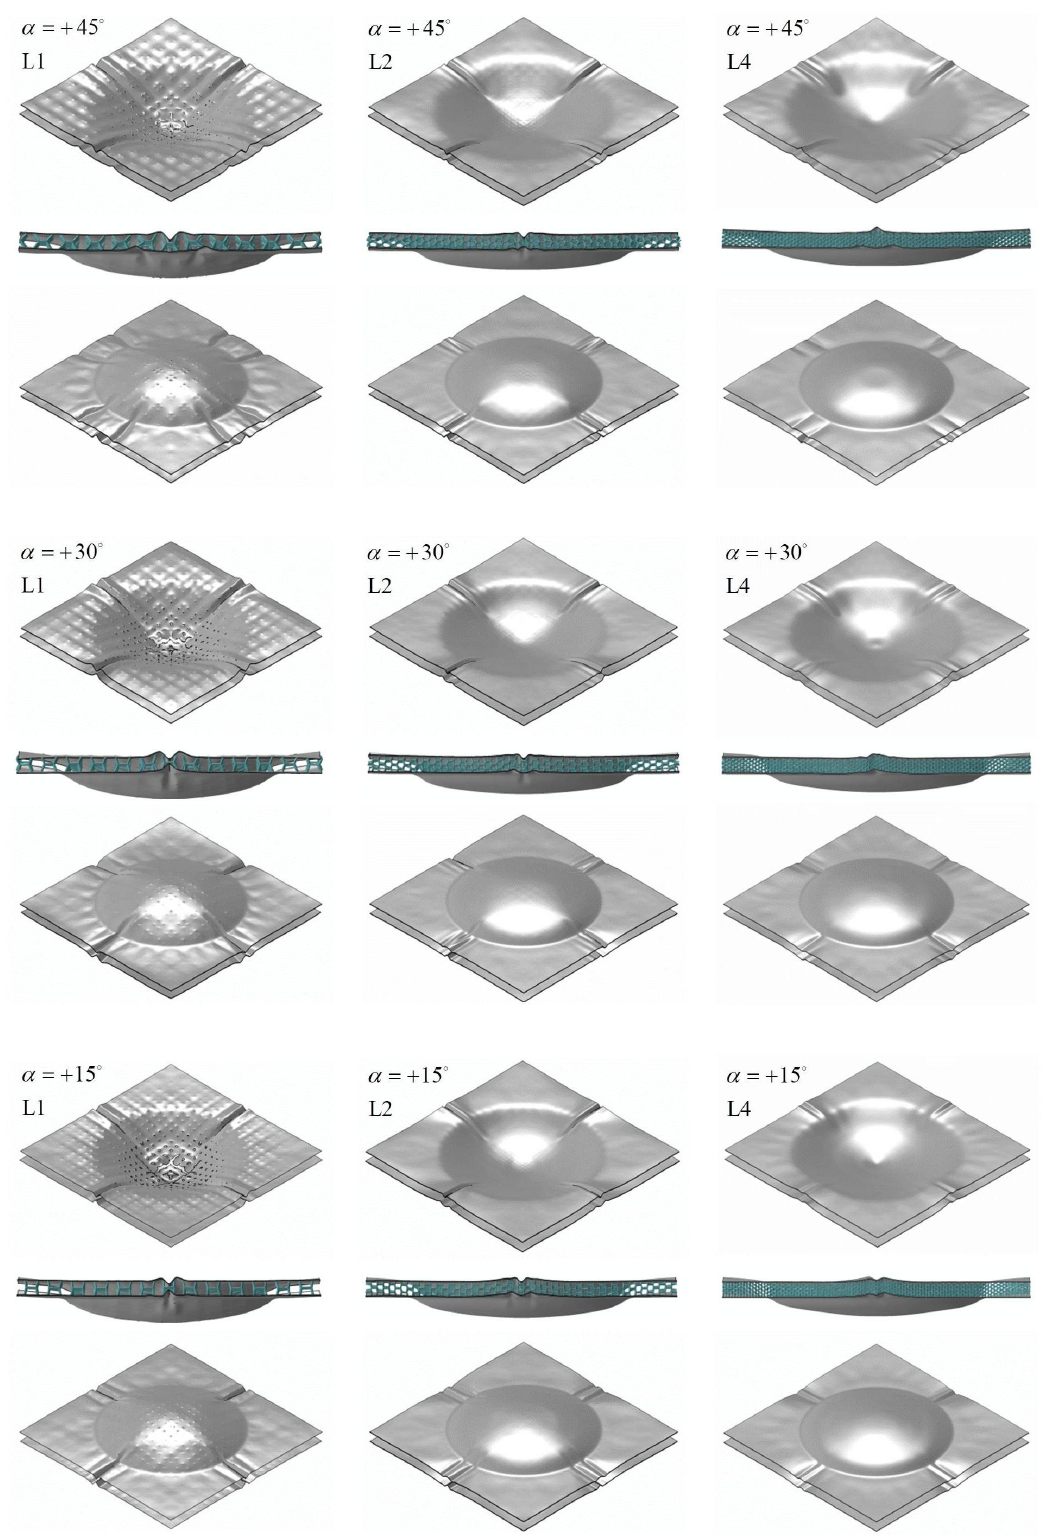
Figure A8. Deformation states of the top and bottom sides for 3D lattice, one- and multi-layered, non-auxetic cores with cell angle α > 0 ◦ subjected to air-blast loading (t = 0.6 ms).